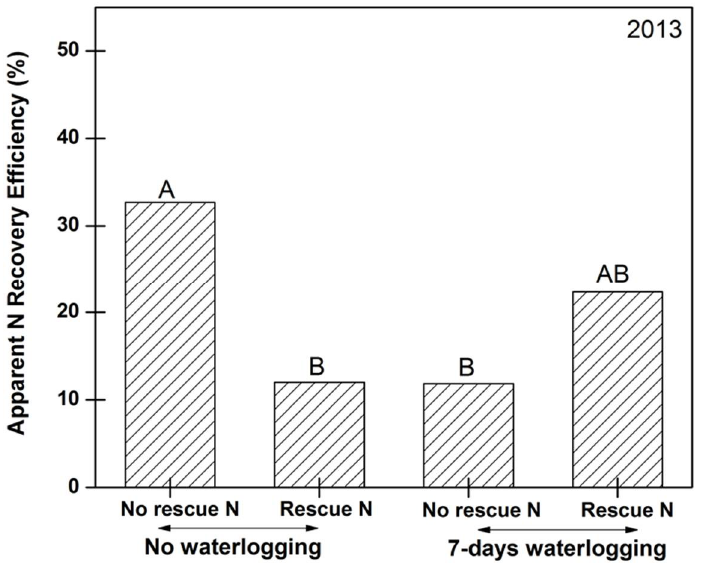
Figure 6. Apparent N recovery efficiency as affected by the interaction between waterlogging duration and rescue N applications in 2013. Similar letter on the bars indicate no significant differences between means at p < 0.10.